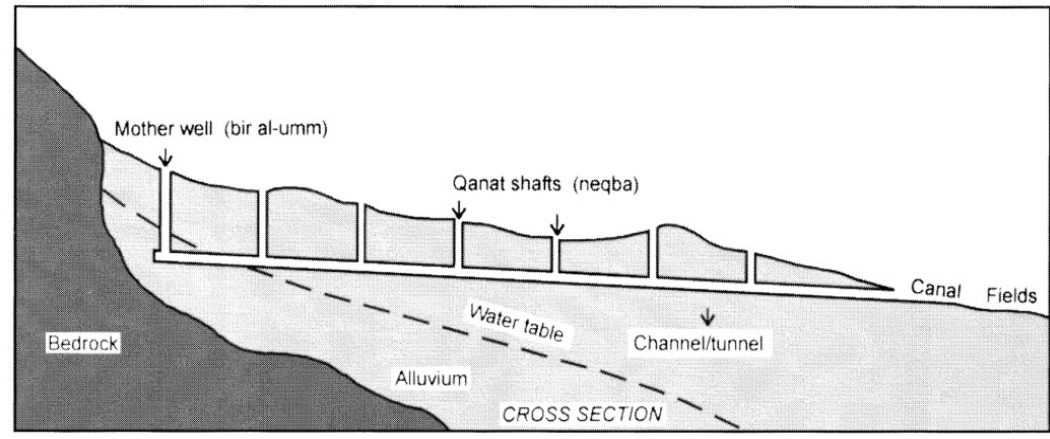
Figure 1. A typical cross-section of a qanat